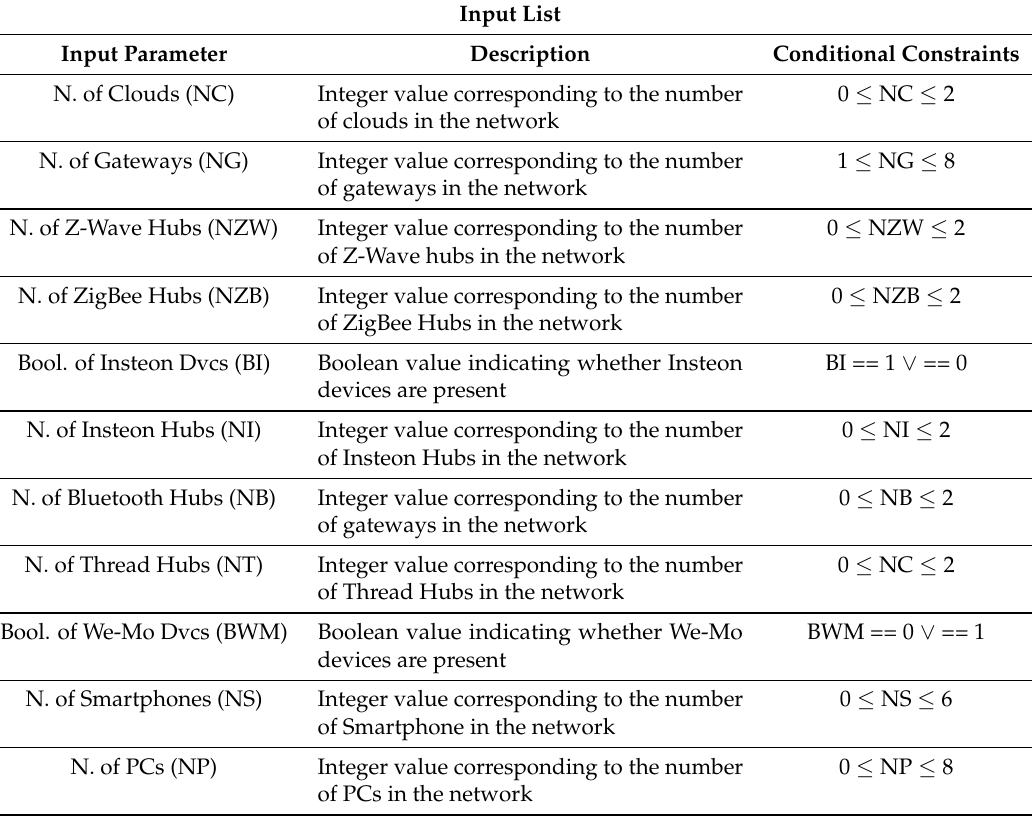
Table 3. Topology generator input parameters